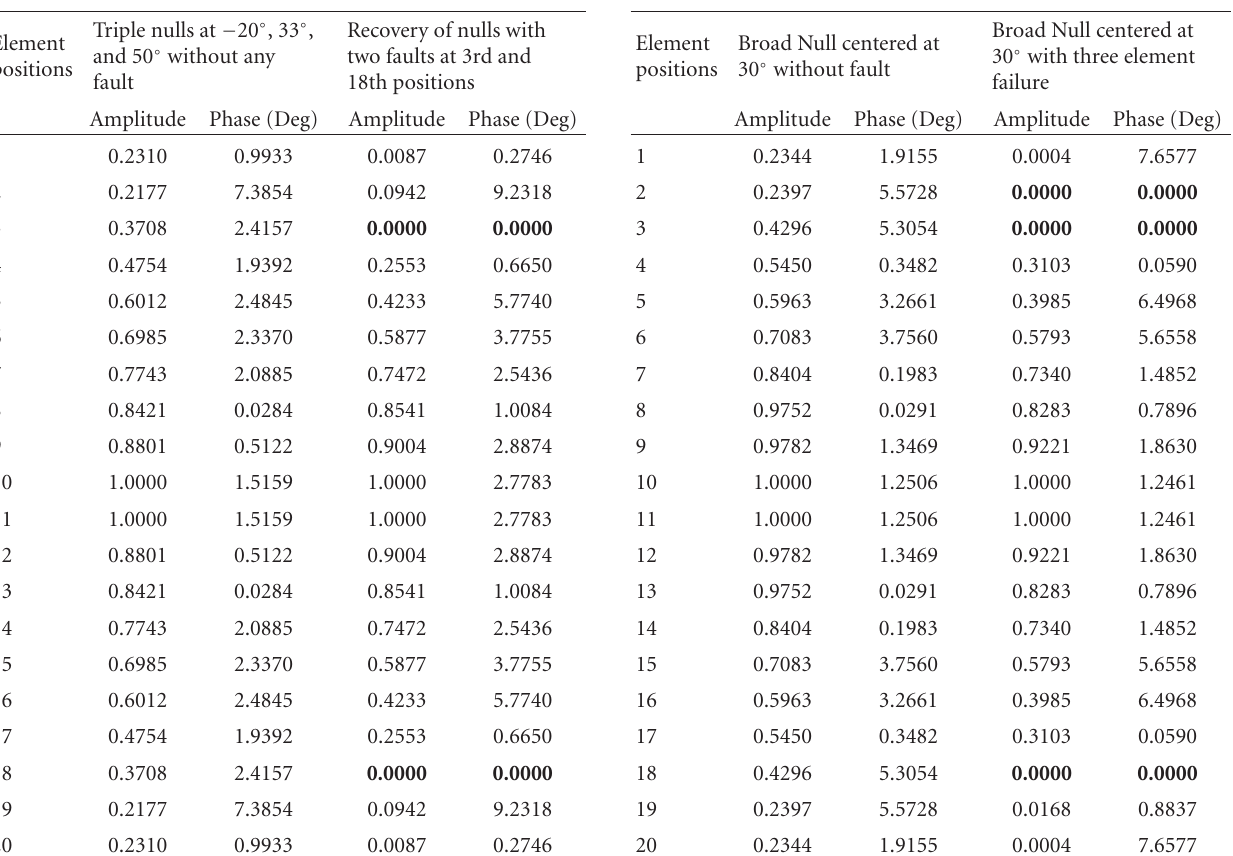
Table 7: Element excitations corresponding to Case 4.